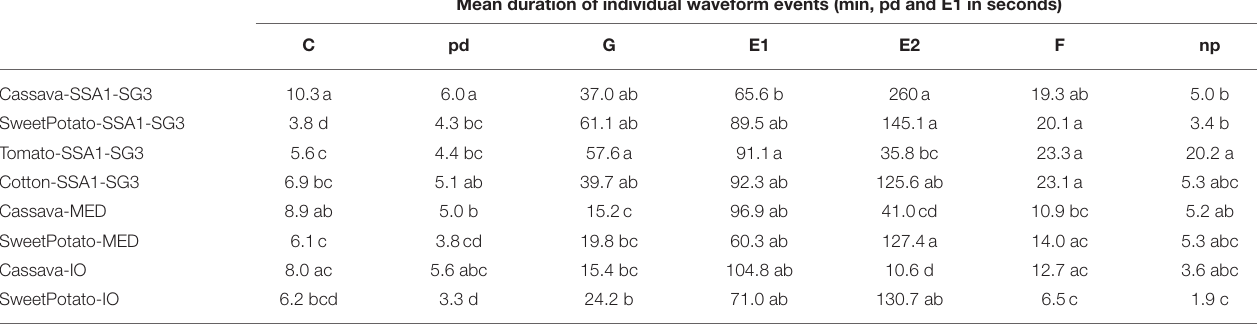
TABLE 1 | Mean durations of individual waveform events. Mean duration of individual waveform events (min, pd and E1 in